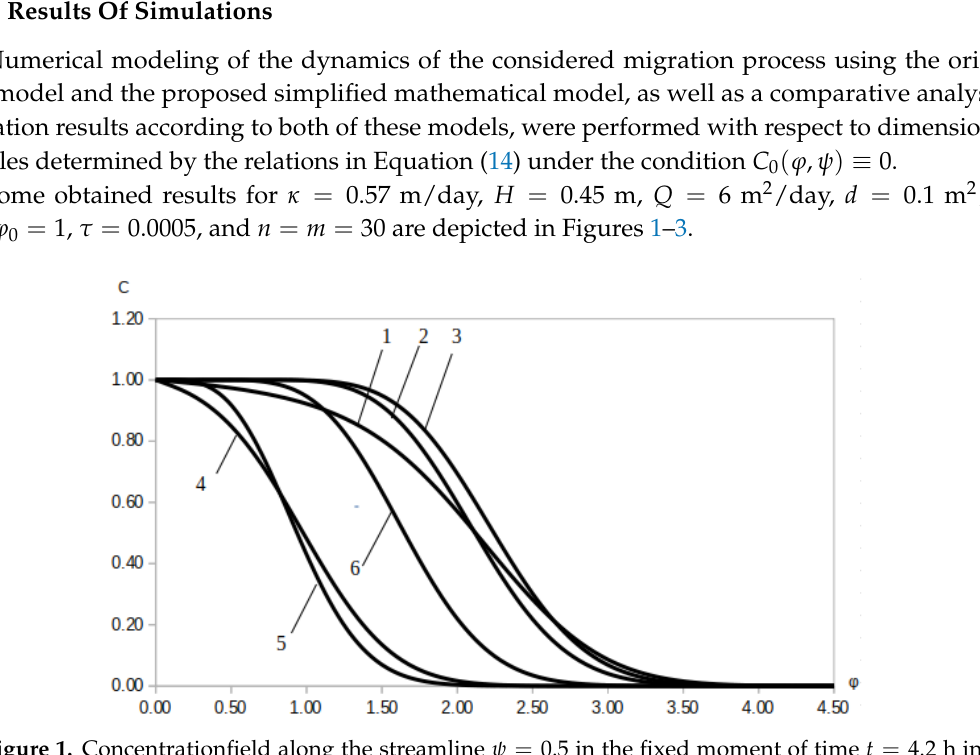
Figure 1. Concentrationfield along the streamline ψ = 0.5 in the fixed moment of time t = 4.2 h in the case of MIM (curves 1,4), simplified (curves 2,5) and classical (curves 3,6) mathematical models (1,2, α = γ = 0.92, β = 0.1; 3, α = γ = 1, β = 0.1; 4,5, α = 0.84, γ = 0.96, β = 0.8; and 6, α = γ = 1, β =